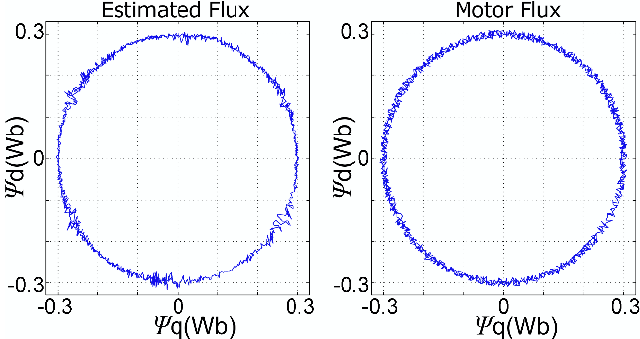
Figure 14. Comparison of fluxes in the q - and d -axes.